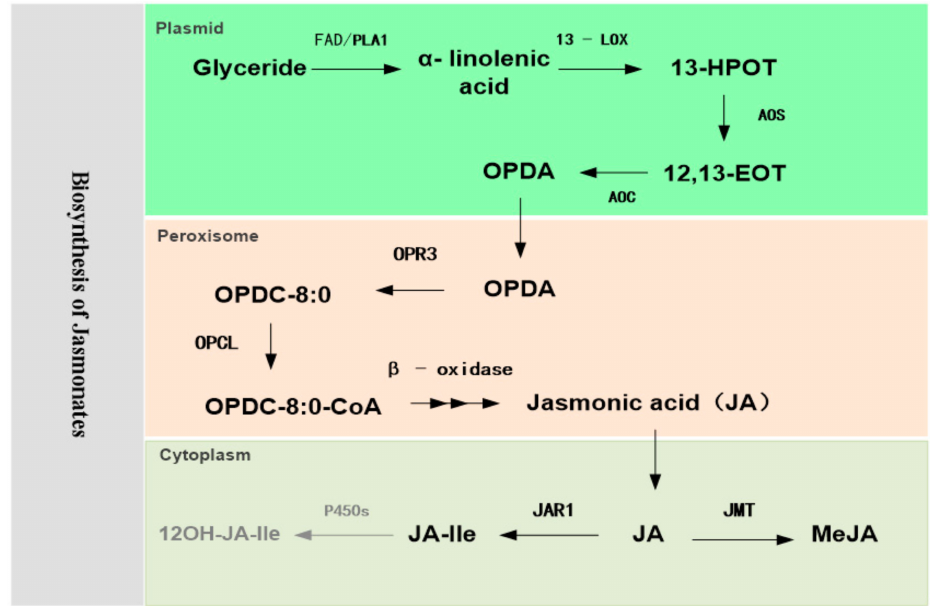
Figure 2. Schematic diagram of the biosynthesis pathway of jasmonates (JAs). Synthesis of JA/JA-Ile from α -linolenic acid generated from glyceride. Abbreviations for compounds: 13-HPOT, (13S)- hydroperoxylinoleic acid; 12,13-EOT, 12,13-epoxyoctadecatrienoicacid; OPDA, 12-oxo-phytodienoic acid; OPDC-8:0, 3-oxo-2(cis-2 (cid:48) -pentenyl)-cyclopentane-1-octanoic acid; PLA1, phospholipase A1; 13-LOX, 13-lipoxygenase; AOS, allene oxide synthase; AOC, allene oxide cyclase; OPR3, OPDA reductase3; OPCL, OPC-8:0 CoA ligase; JAR1, JA–amino acid synthetase; JMT, jasmonic acid carboxyl methyltransferase; CYP94B3, cytochrome P450